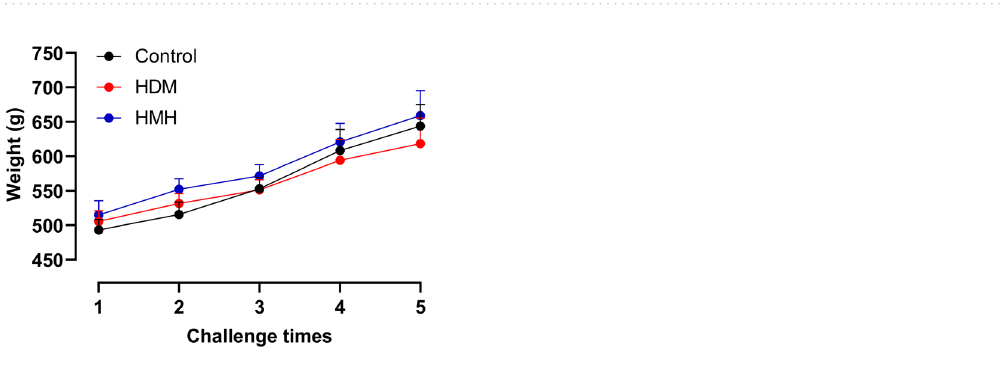
Figure 8. Weight curves of guinea pigs. The weights of animals from the first to the fifth challenge. Control: animals exposed to PBS, received vehicle (12.5% EtOH/PBS) or monensin as pretreatment. HDM: animals exposed to HDM and received vehicle as pretreatment. HMH: animals exposed to HDM and received monensin as pretreatment (n = 6–7 in each